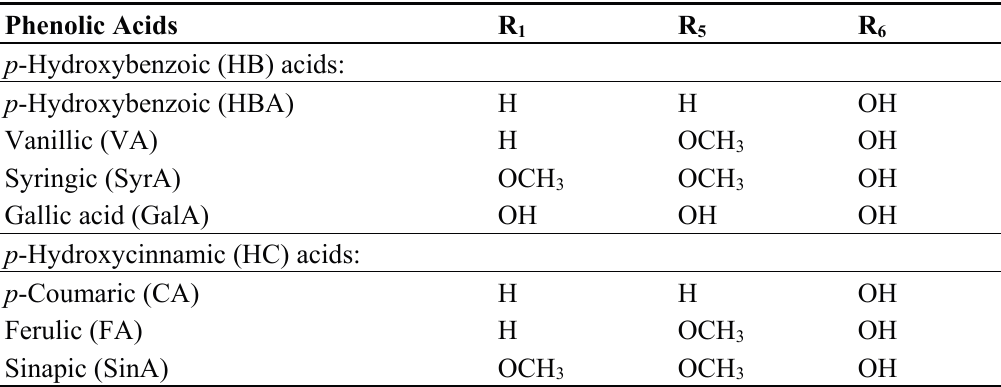
Table 1. Substituents in the HB and HC acid